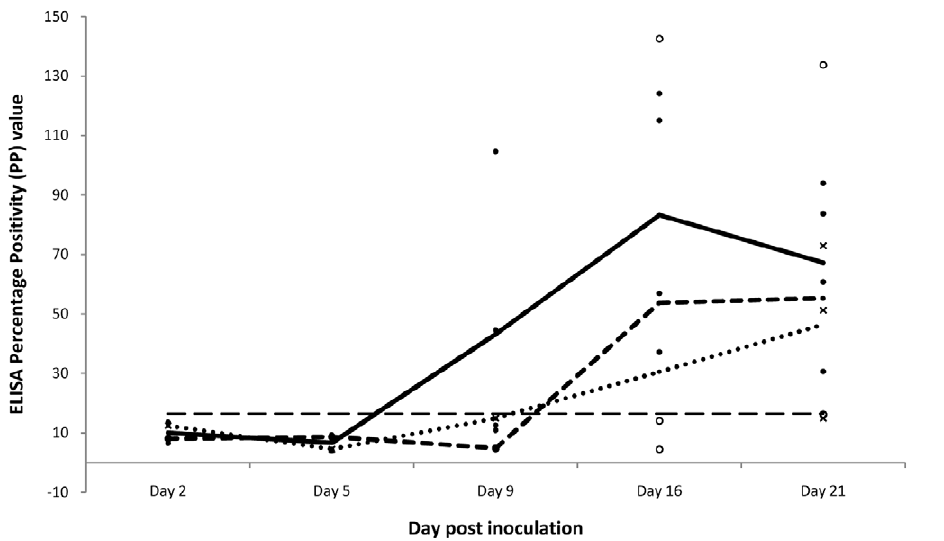
N ), adult males NNN ) are shown. The ELISA cut-off value is indicated as a dashed